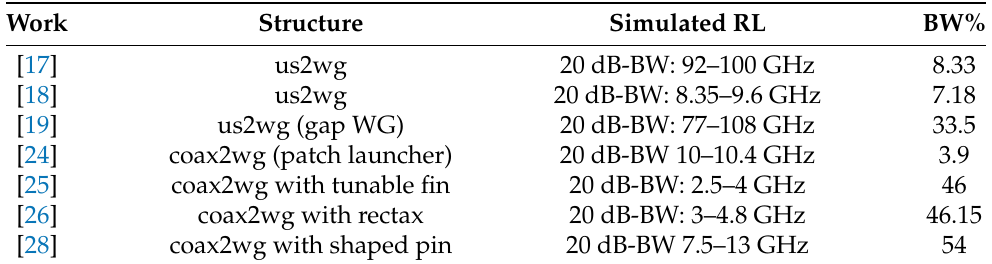
Table 2. A comparative table on performance of the different transitions proposed in